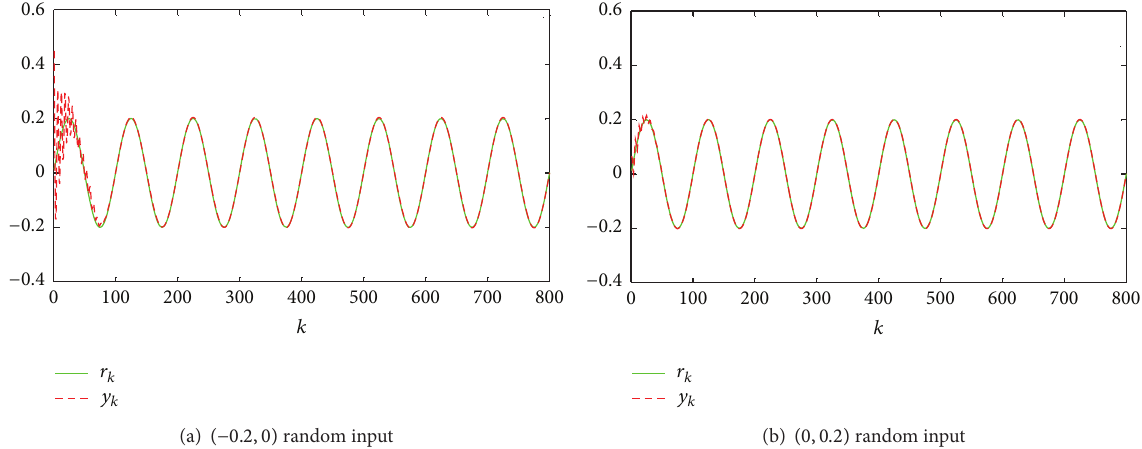
Figure 5: OS-ELM control results with different initial training samples.